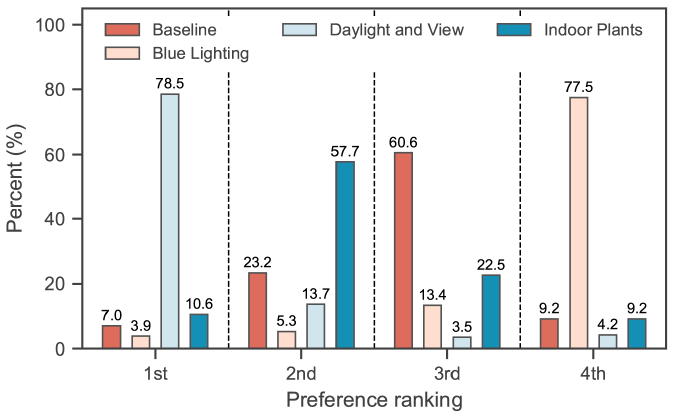
Figure 3. The distribution of preference ranking of the four indoor designs.